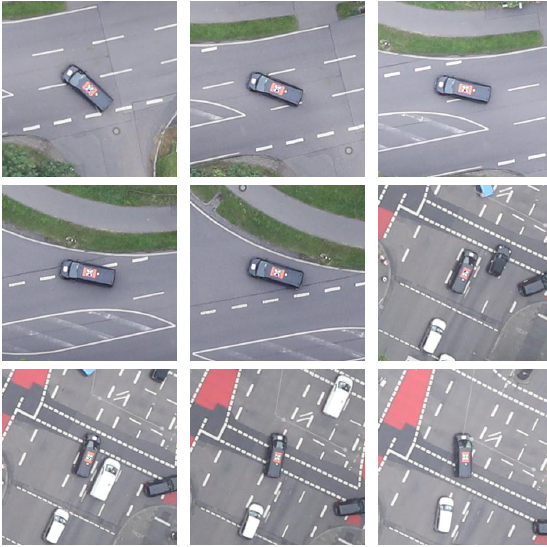
Figure 7. Examples of aerial image sequences with the cross center in the middle of the image patch.